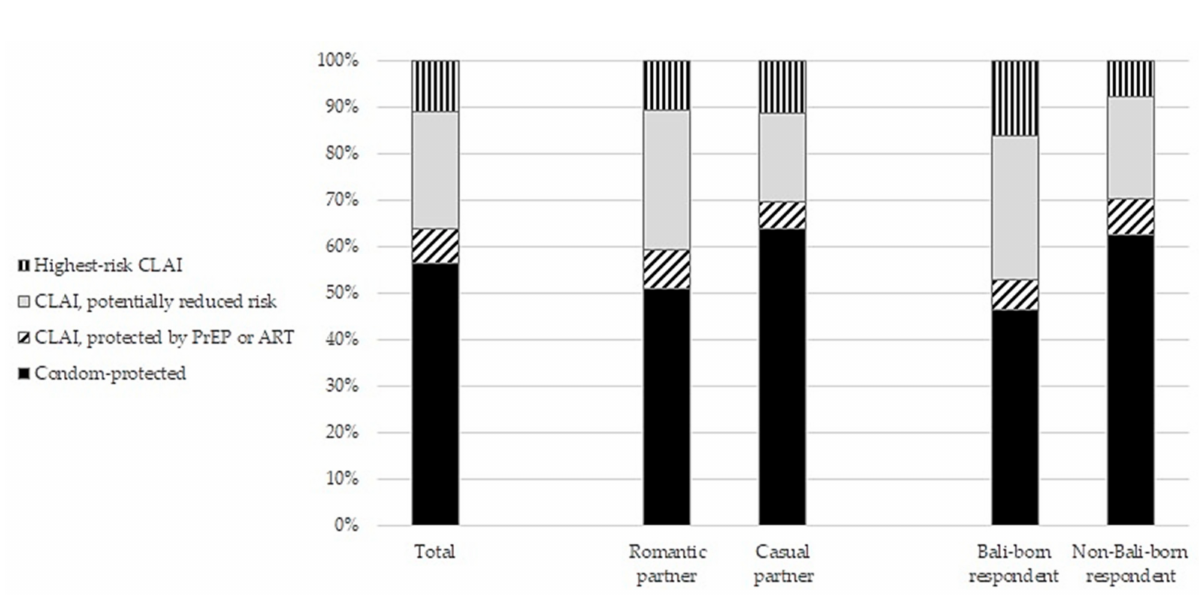
Figure 1. Comparison of classifications of the most recent anal intercourse event: total ( n = 703); by partner type (romantic partner, n = 397; casual partner, n = 306); and by respondent place of birth (Bali-born, n = 263; non-Bali-born, n = 440). CLAI, condomless anal intercourse; PrEP, pre-exposure prophylaxis; ART, antiretroviral